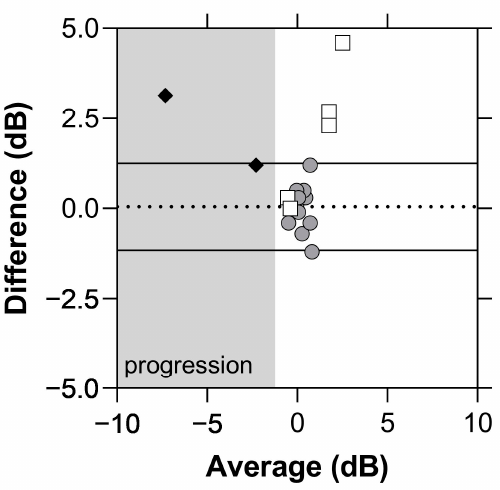
Figure 8. Bland–Altman plot of the HFA guided progression analysis (GPA, MD slope, dB/yr) and MRFh MD trend in glaucoma participants with no progression (filled circles, n = 18). Progressors (grey shaded area, black diamonds, n = 2) were not included in the Bland–Altman analysis. The unfilled square symbols identify 5 cases who showed significant learning effects (change or fluctuation > 3.7 dB over the 12 month period). Some of these cases returned ‘improved’ thresholds at later times, which produce an artefactual improvement in their outcomes. Average difference: 0.05 dB/yr. 95% Limits of agreement: − 1.1 to 1.2 dB/yr.